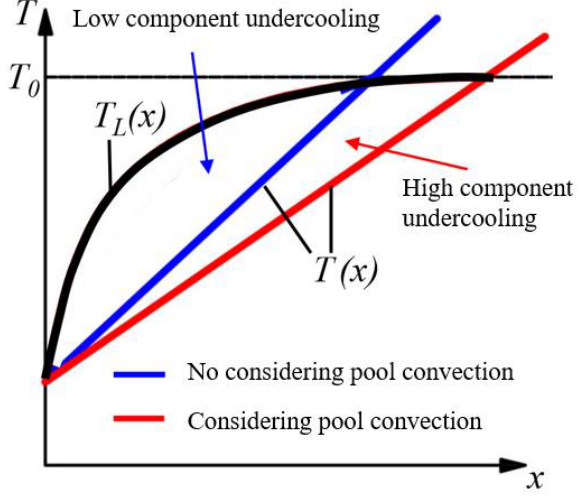
Figure 20. Model of the influence of pool convection on the “ component supercooling ” .